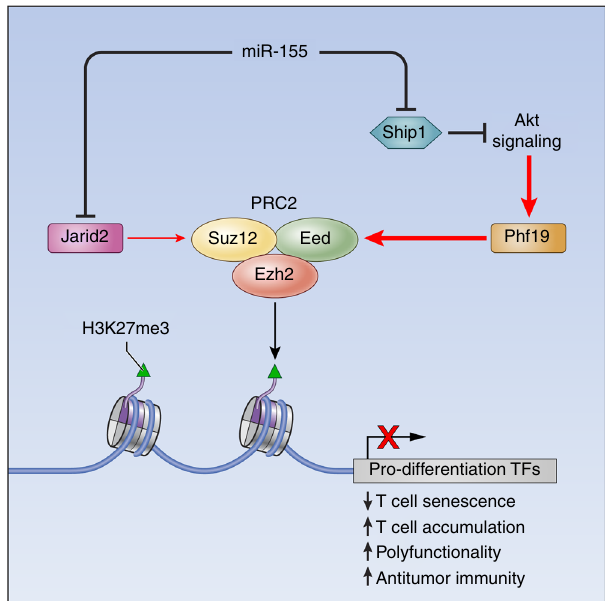
Fig. 8 The miR-155-PRC2 circuitry potentiates antitumor immunity by epigenetically reprogramming CD8 + T cell fate. Cartoon depicting the regulatory circuitry by which miR-155 epigenetically reprograms CD8 + T cell fate and function via enhancement of PRC2 activity.